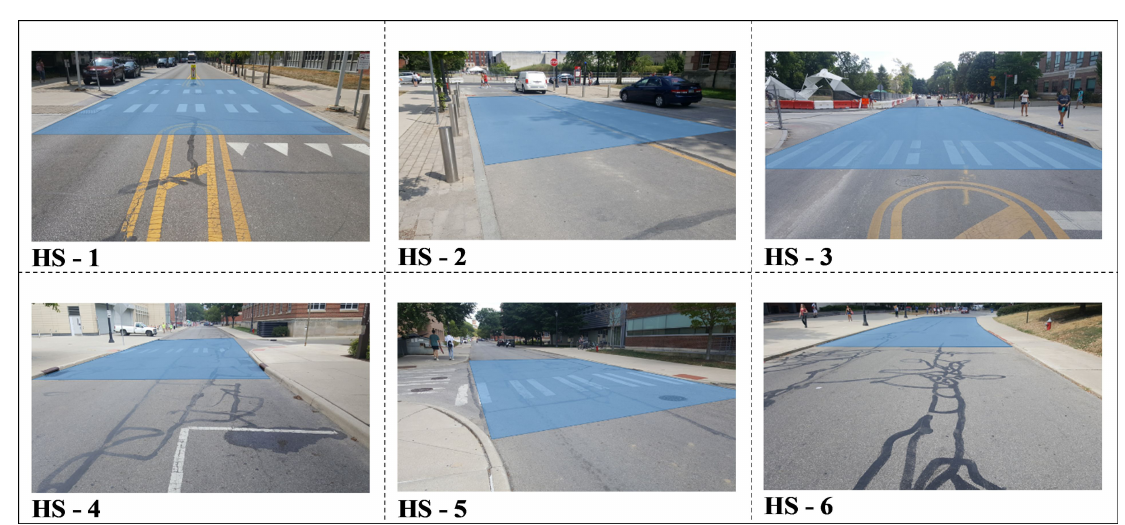
Figure 11. Vertical reference surfaces.